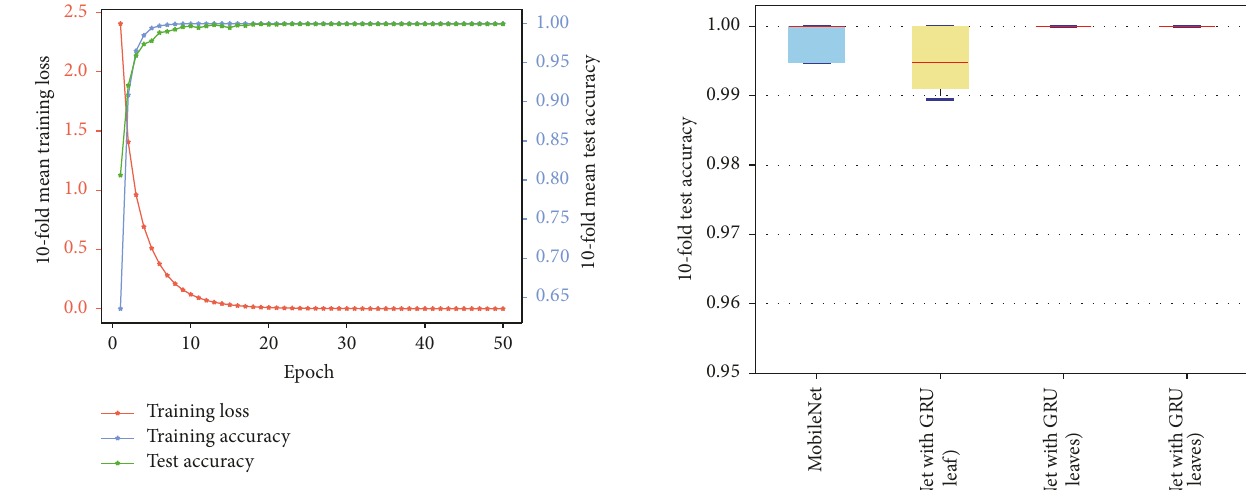
Figure 4: The mean of training loss, training accuracy, and test accuracy of the MobileNet with GRU model in one fold.